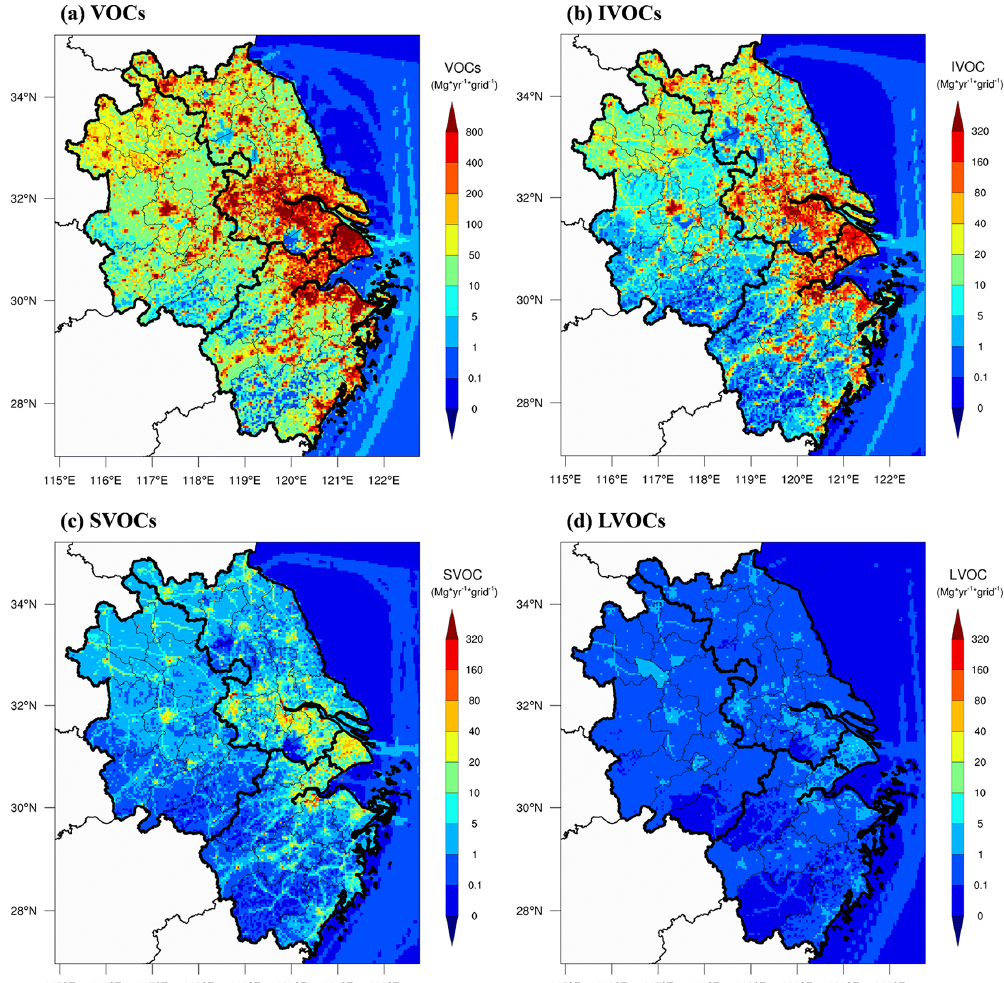
Figure 3. Spatial distributions of anthropogenic VOC, IVOC, SVOC, and LVOC emissions in the YRD region for the year